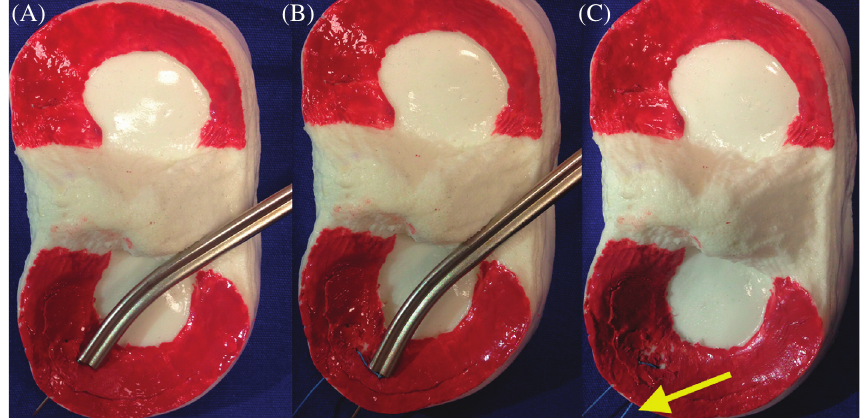
Figure 2. Application of the inside-out suture as the first suture in our hybrid technique. (A) Insertion of the first leg of the suture from the posterior. (B) Insertion of the second leg of the suture from the anterior. (C) Fixation of the suture with the meniscus reduced.